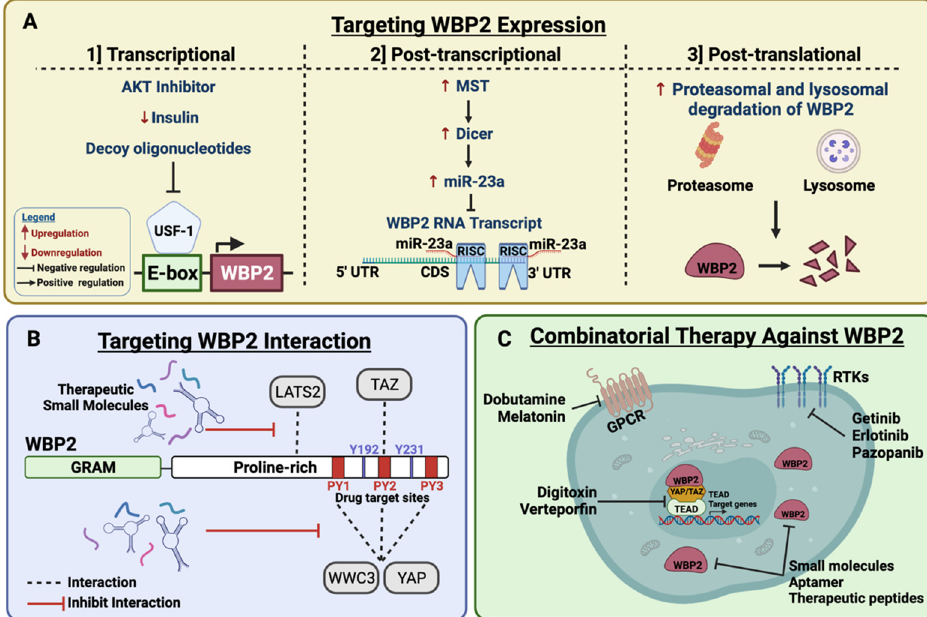
Figure 8. Summary of WBP2 translational implications in Hippo-dysregulated cancers. ( A ) Targeting WBP2 expression could be carried out at the transcriptional, post-transcriptional and post-translation levels. ( B ) Targeting WBP2 interacting partners could be facilitated by the design of small molecules that target the PPxY motifs in the C terminus of WBP2. This is expected to block the interaction of WBP2 with its interacting partners in the Hippo pathway to subvert WBP2-driven cancer progression. ( C ) Combinatorial therapy involving potential WBP2 inhibitors and other therapeutics to improve treatment efficacy and reduce possible side effects. Created with BioRender.com .